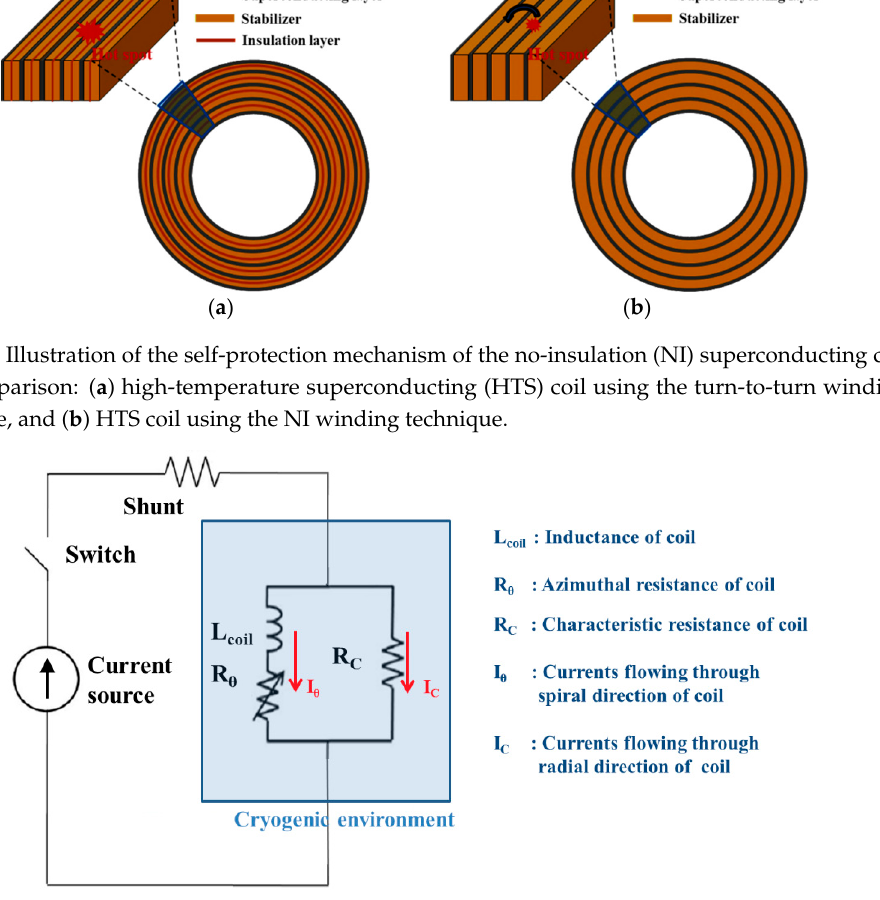
Figure 2. Simplified equivalent circuit model of the NI HTS coil.